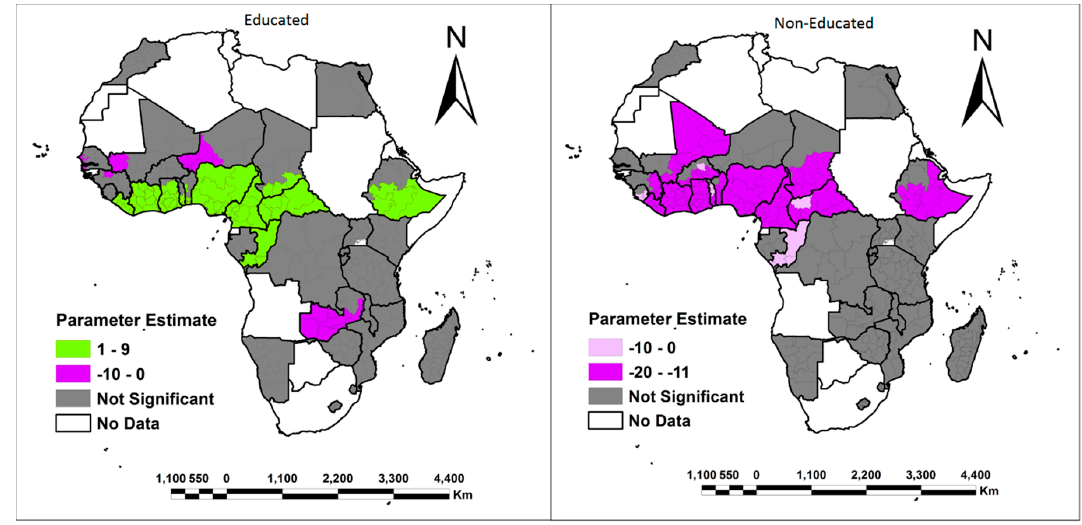
Figure 6. Spatial distribution and significance of education on women’s access to family land.